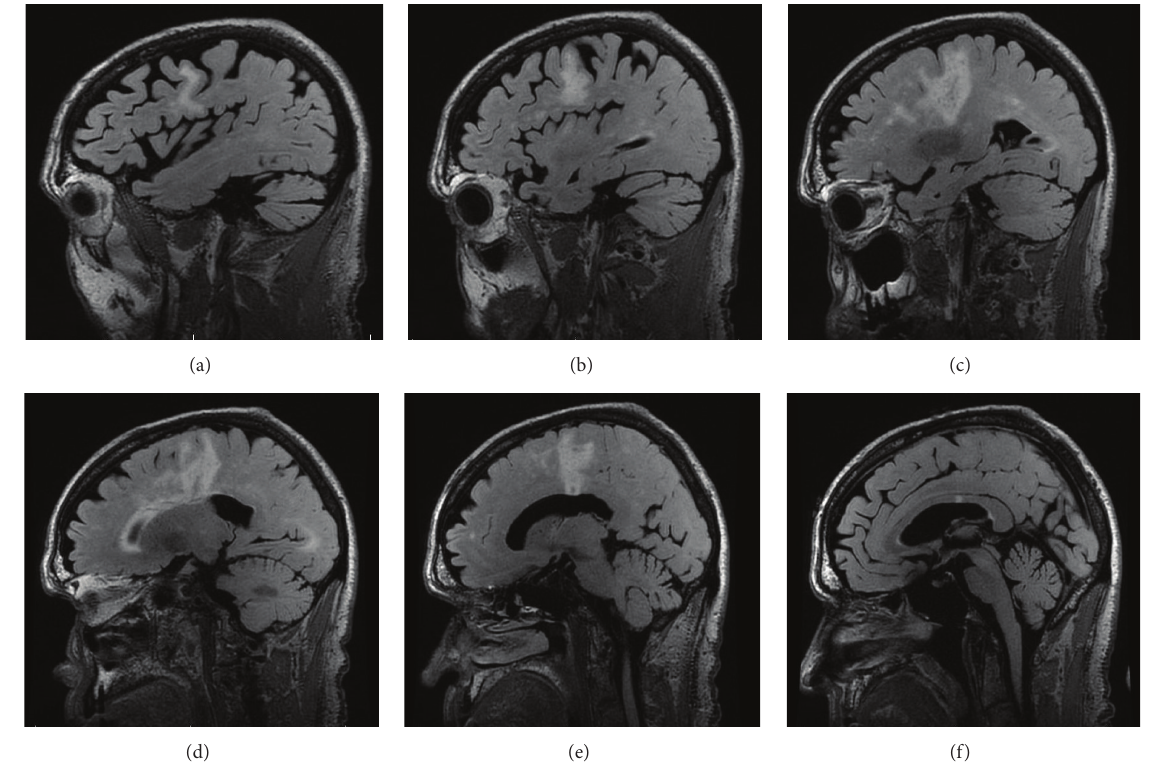
Figure 2: Sagittal images of MRI of the brain with T2-weighted FLAIR hyperintensities. Images progress from left to right from (a) through (f). Areas of demyelination correspond anatomically with axial images from Figure